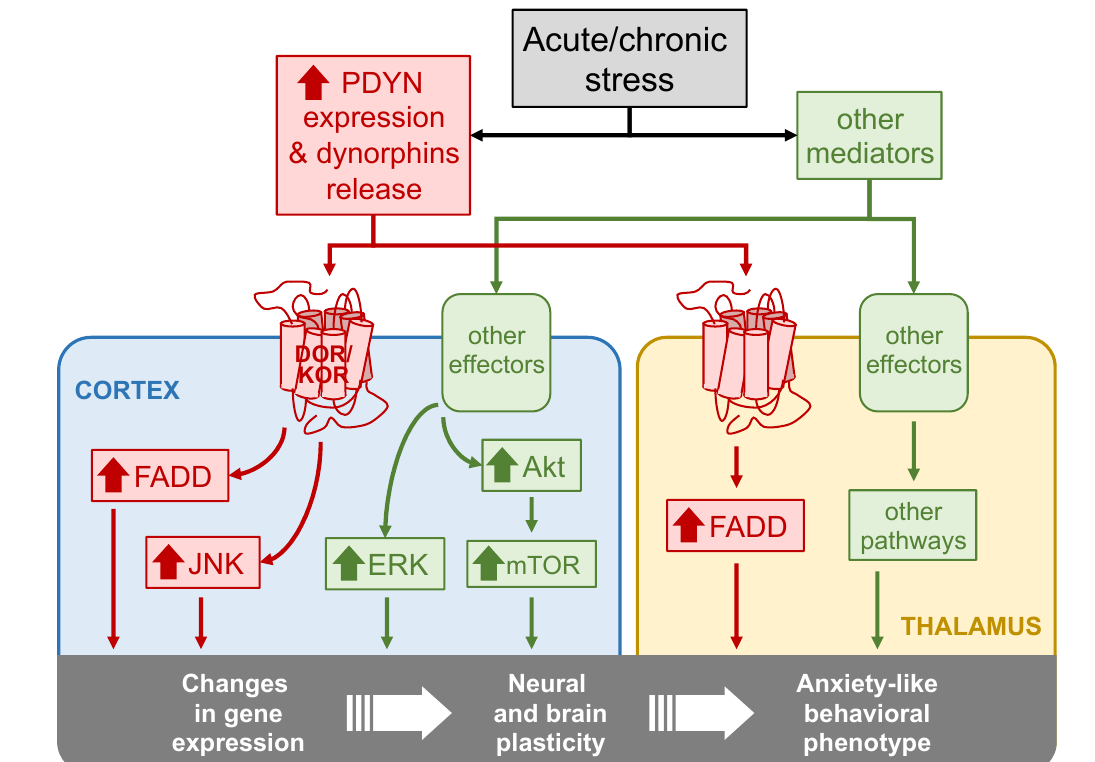
Figure 6. Flow diagram summarizing the major findings of the study.